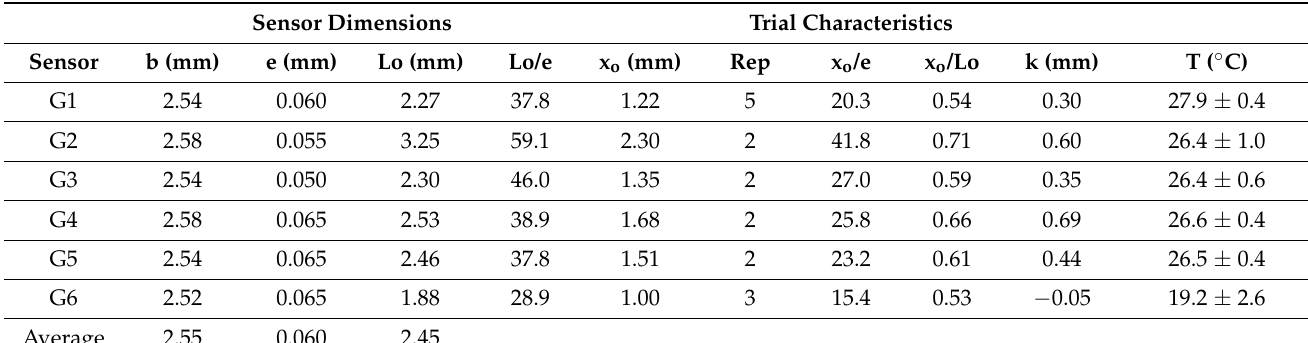
Table 1. Dimensions of the strain gauge sensors and characteristics of the bending tests. Sensor